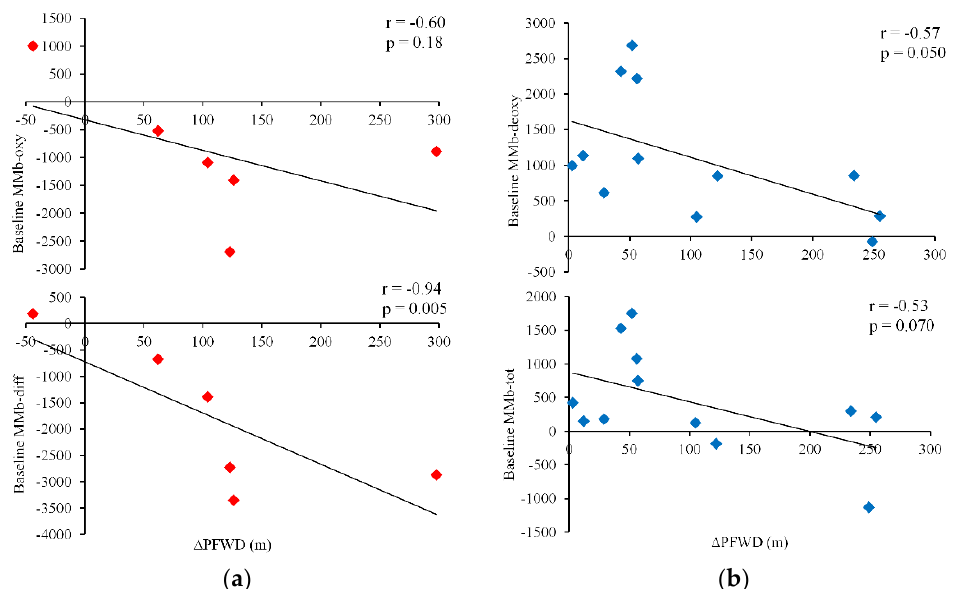
Figure 4. Predictive correlations between baseline values of MMb and variations of pain-free walking distance 4-month after interventions. ( a ) revascularization; ( b ) exercise. PFWD: pain-free walking distance.